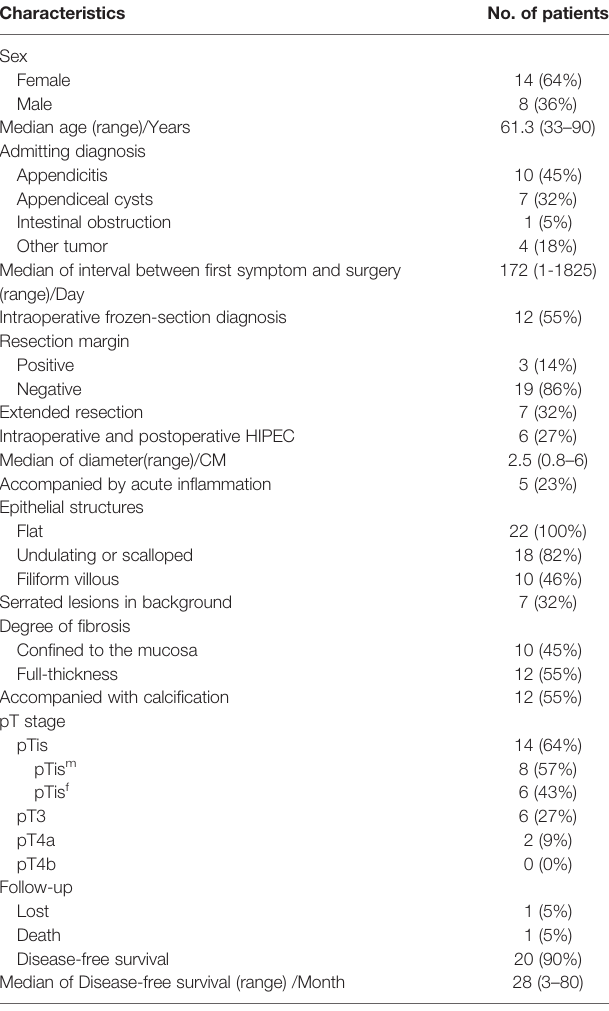
TABLE 1 | Clinicopathological features of LAMNs con fi ned to